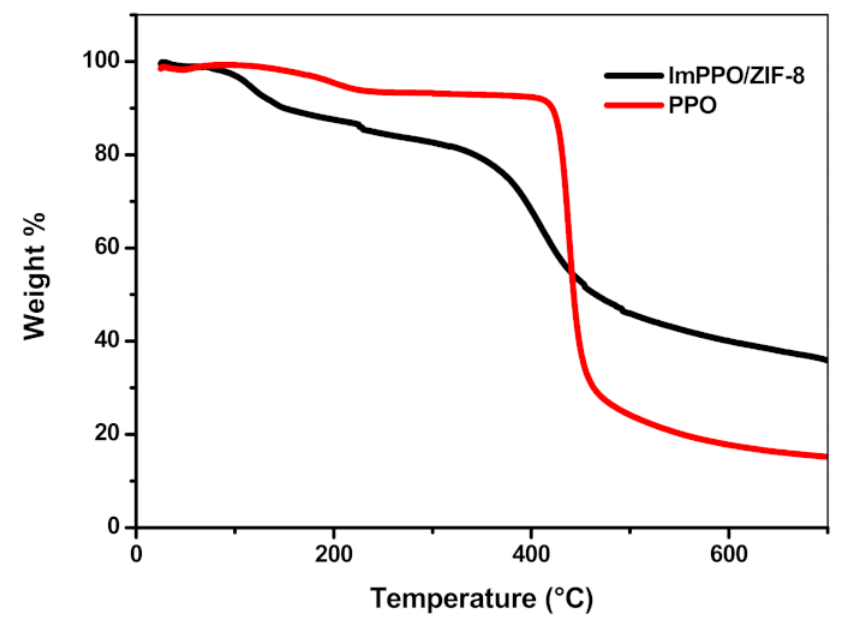
Figure 8. Thermogravimetric analysis (TGA) graphs of PPO and ImPPO/ZIF-8